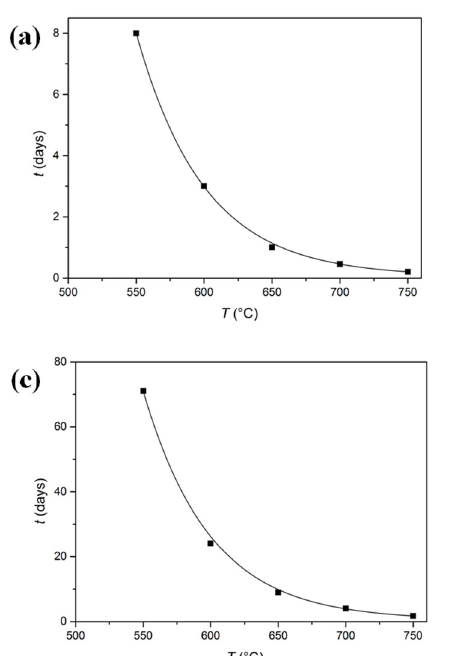
Figure 8. Fitting curves of the required diffusion time of the Sn-rich layer with different thicknesses as a function of temperature: ( a ) 0.1 mm; ( b ) 0.2 mm; ( c ) 0.3 mm; ( d ) 0.6 mm.